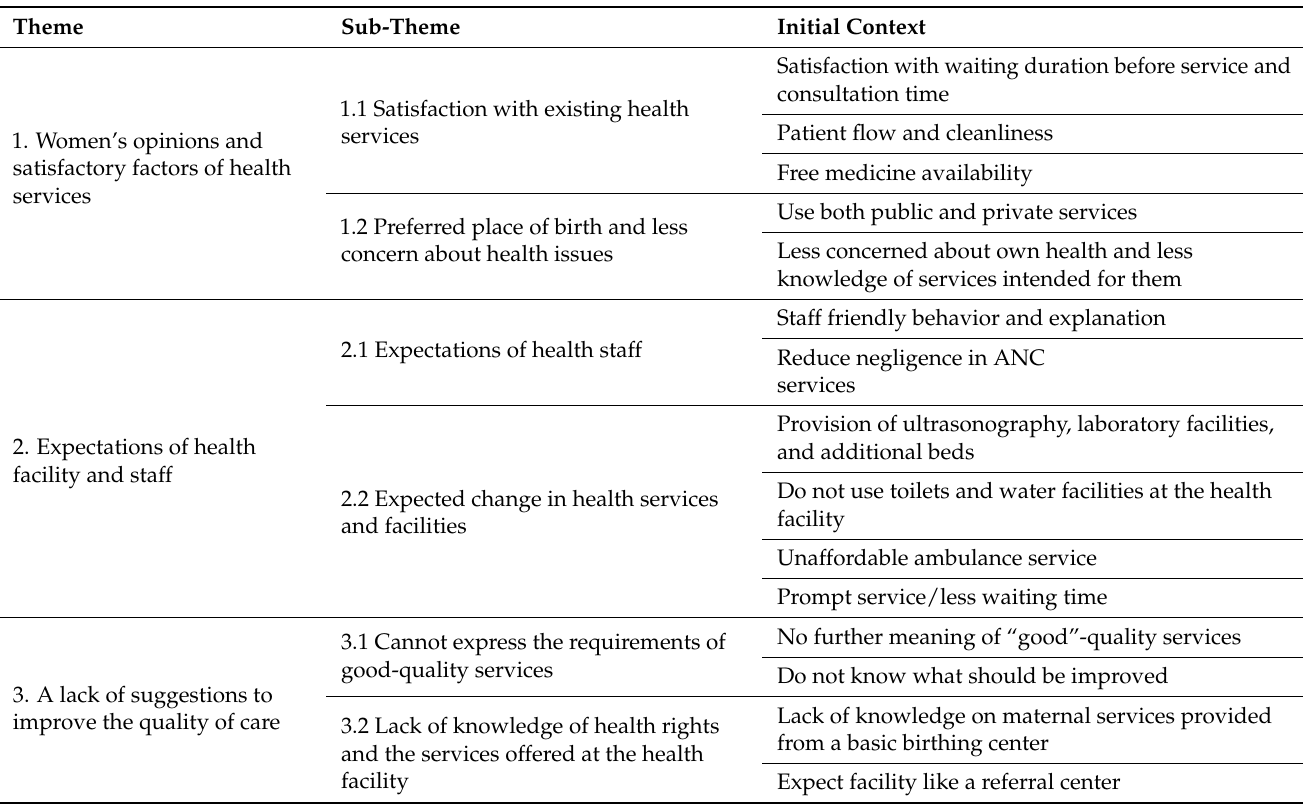
Table 1. Initial context, subthemes, and themes for the quality of antenatal care and birthing services. Theme